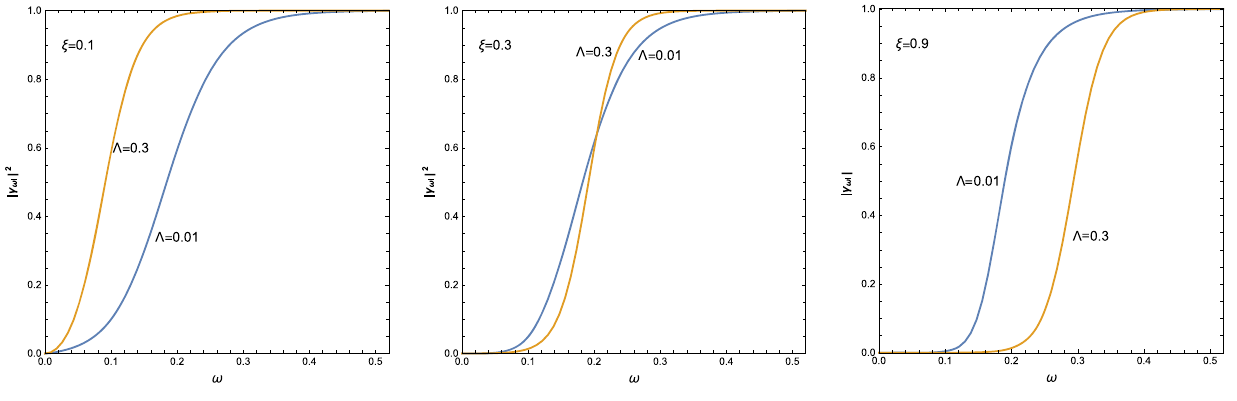
Fig. 4 Effect of (cid:3) on the greybody factor. We fix l = 0 ,α = 0 . 3